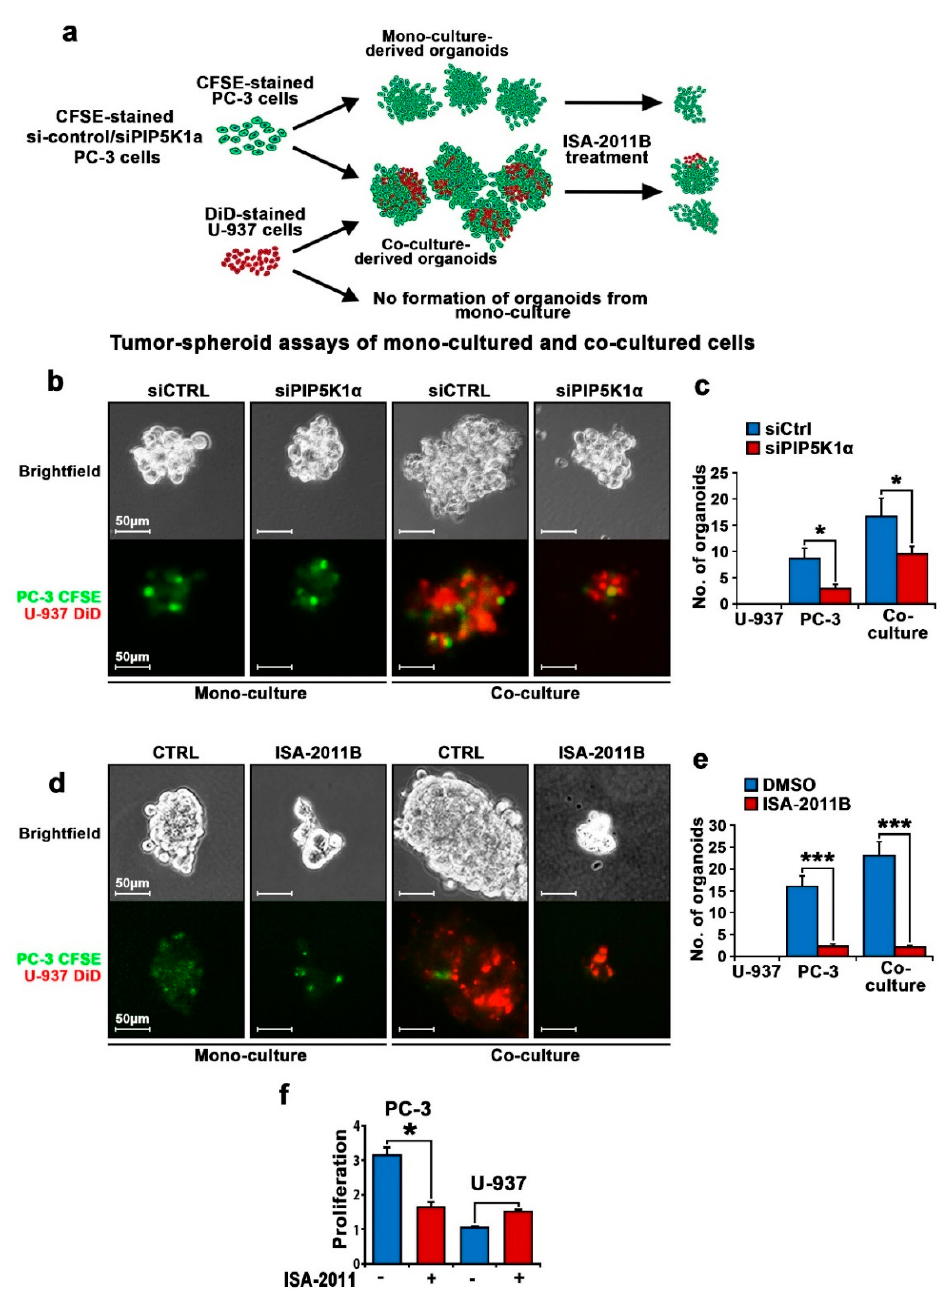
Figure 6. The effect of PIP5K1 α inhibition on the interaction between PC-3 cells and U-937 cells. ( a ) Schematic chart depicting the experimental procedures of the establishment of PCa tumor spheroids using mono-cultured or co-cultured PC-3 cells transfected with control siRNA or siPIP5K1 α RNA with U-937 cells, or mono-cultured PC-3 vs. co-cultured tumor spheroids treated with vehicle control or ISA-2011B. U-937 cells were stained with DiD and were co-cultured with PC-3 cells that were stained with carboxyfluorescein diacetate succinimidyl ester (CFSE). ( b ) Representative images of the micro-photographs of tumor spheroids taken under the confocal microscope to visualize tumor cells within tumor spheroids derived from mono-cultured si-control PC-3 cells or siPIP5K1 α -PC-3 cells, or the interaction between PC-3 cells and U-937 cells in tumor spheroids derived from the co-cultured cells, are shown. ( c ) The tumor-spheroid counts from different groups are shown. Mono-culture p = 0.017; co-culture, p = 0.047. ( d ) Representative images of the micro-photographs of tumor spheroids to visualize tumor cells within tumor spheroids derived from mono-cultured or co-cultured PC-3 cells treated with vehicle control or ISA-2011B. ( e ) The tumor-spheroid counts from different groups are shown. p < 0.001 as indicated by “***”. ( f ) The comparison of the effect of ISA-2011B on the proliferation of PC-3 cells and U-937 cells, respectively. p < 0.05 as indicated by “*”.